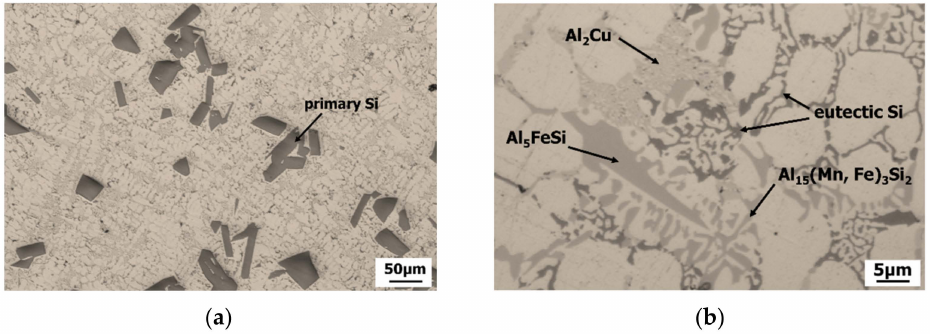
Figure 2. Microstructure of the initial B390 showing: ( a ) a dendritic α -Al phase, primary Si, and ( b ) eutectic phases.